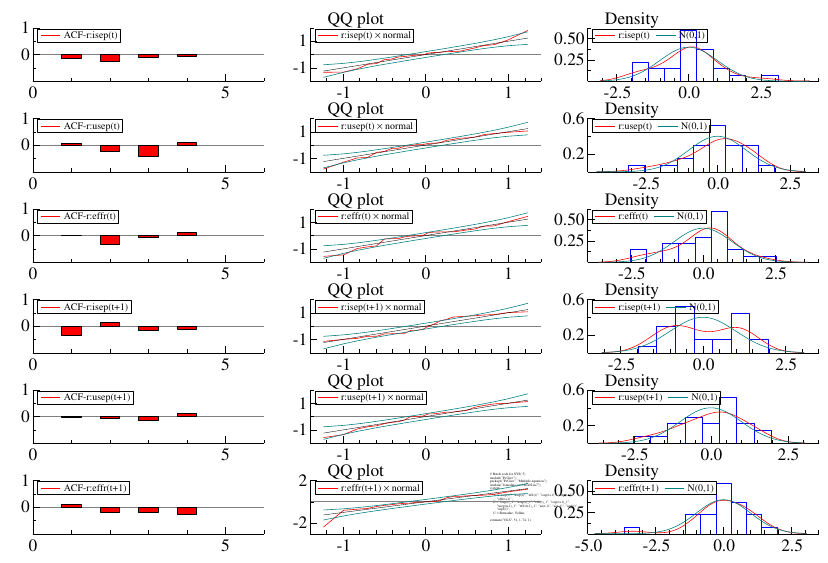
Figure 8. Tests of Serial Independence and Normality of Disturbances for VAR.